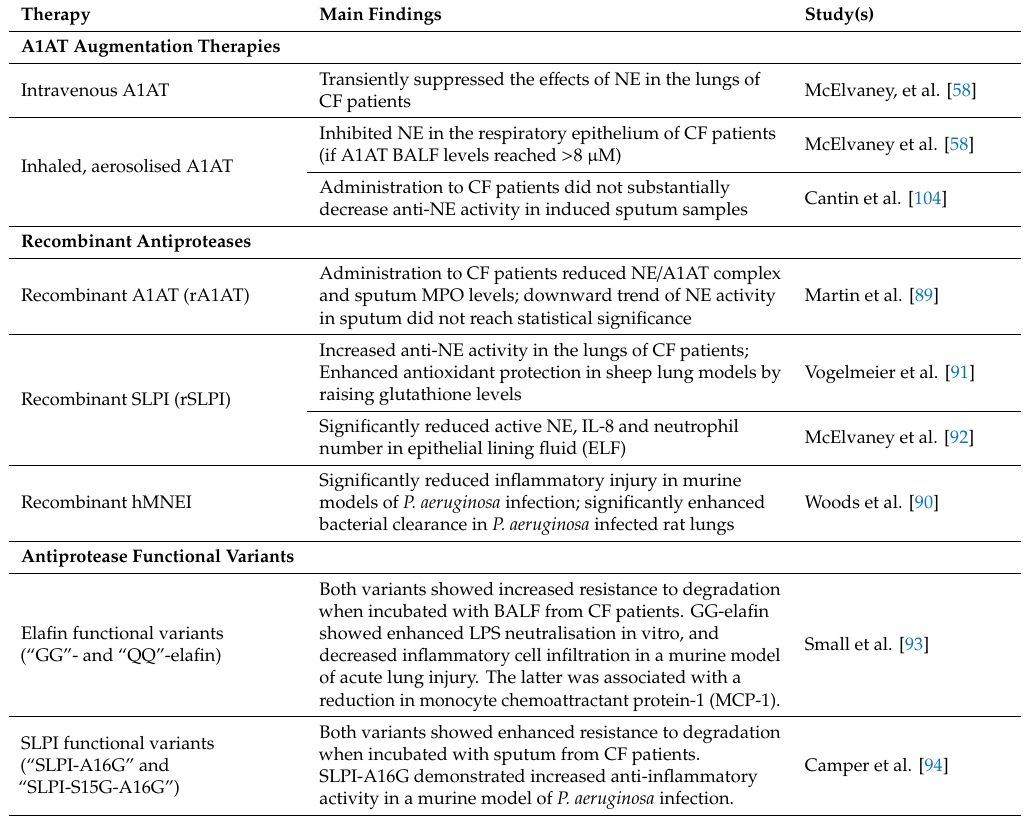
Table 1. Antiprotease therapies in cystic fibrosis